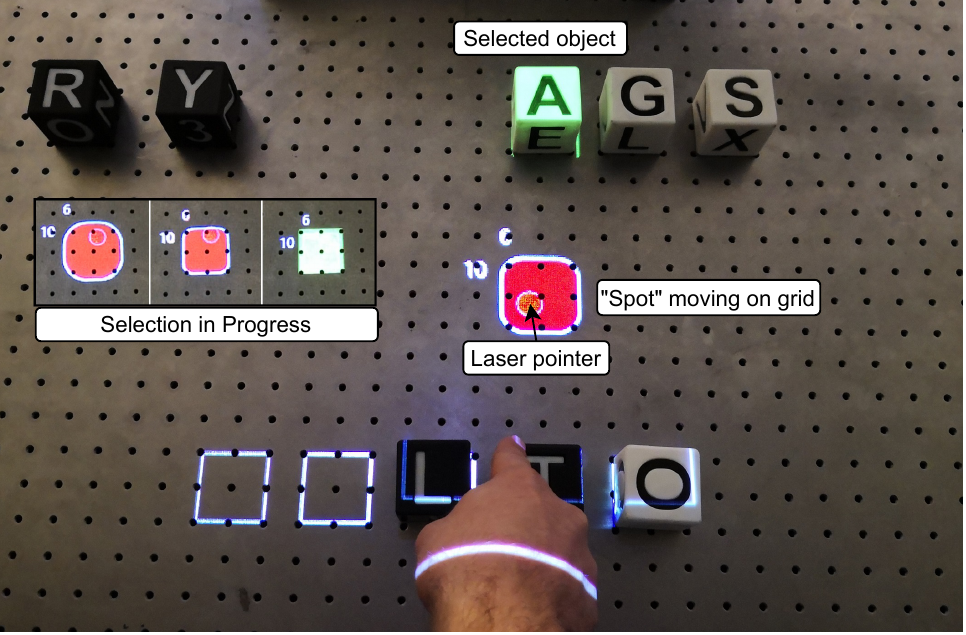
Figure 5. Selection in progress: The borders of the grid rectangle around the laser pointer are narrowing. In the next step, the selection would be moved from Cube A to the new